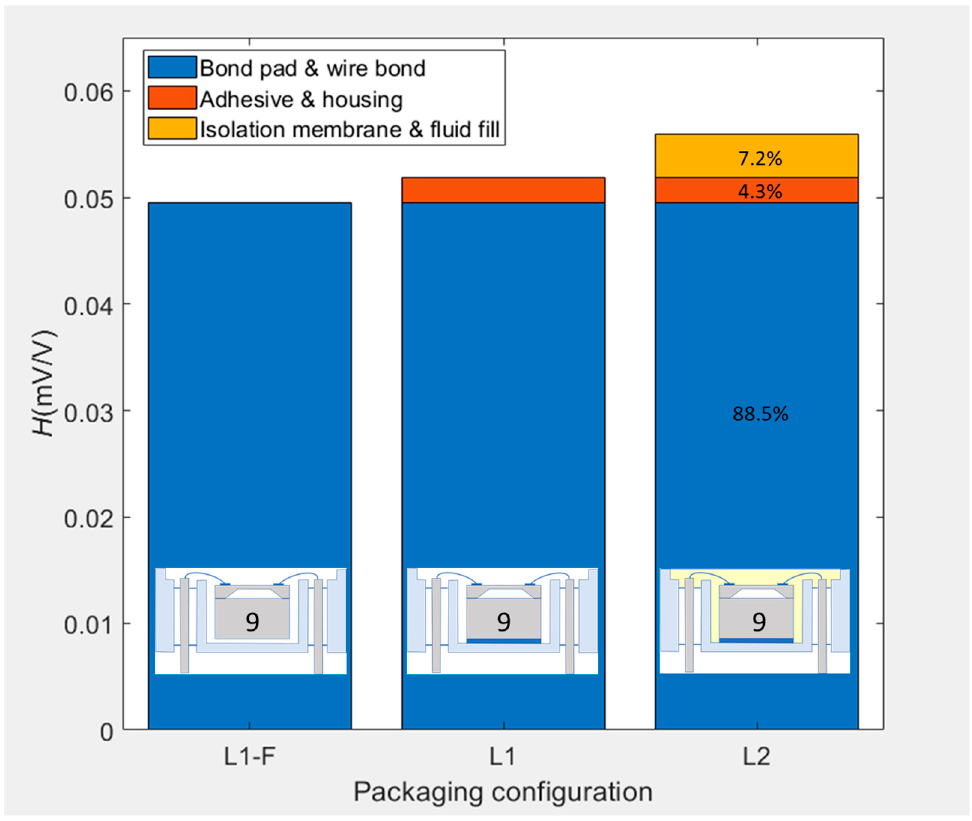
Figure 9. Stacked hysteresis values for − 40 to 125°C cycling of sensing element #9 for each packaging configuration.